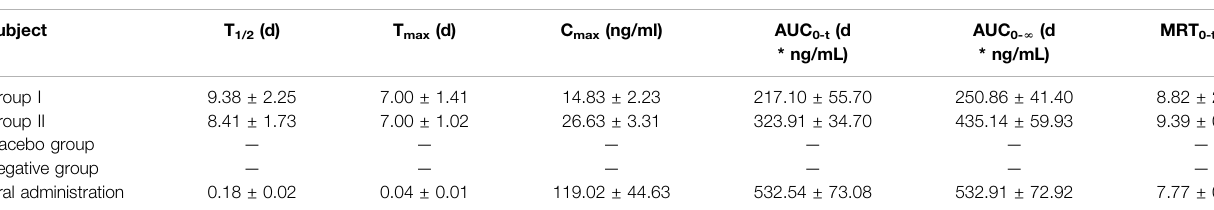
TABLE 7 | Pharmacokinetic parameters of rats following i.m. administration of GLT-PM-MS (mean ± SD, n (cid:2)